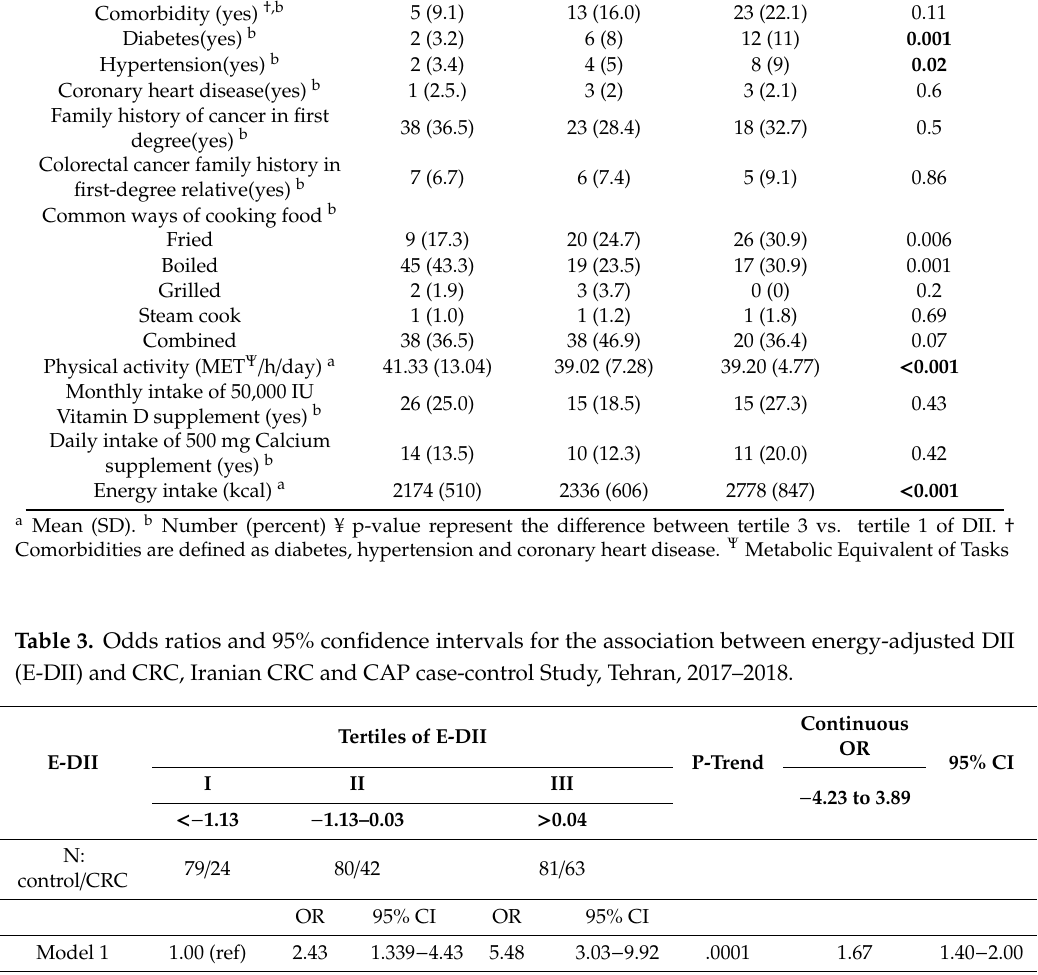
Model 1. Adjusted for age and sex. Model 2. Adjusted for Age, Sex, Physical Activity, Level of salt intake, Diabetes, Hypertension, Coronary heart disease, Smoking, Family history of cancer in first degree, Common ways of